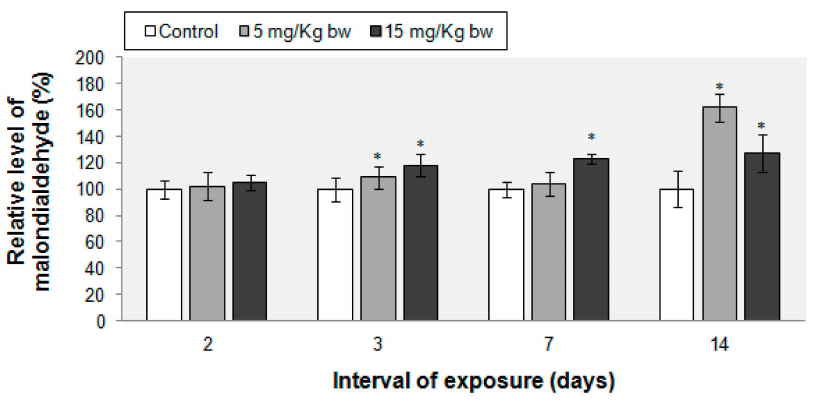
Figure 6. Malondialdehyde level in CD-1 mice lung tissue after exposure to IONPs-PM. Data represents the relative mean ˘ standard deviation of seven animals per group. The values are expressed in percentages relative to control (100%). The difference between the treated group and the control group was significant when * p < 0.05, α (significance level) =